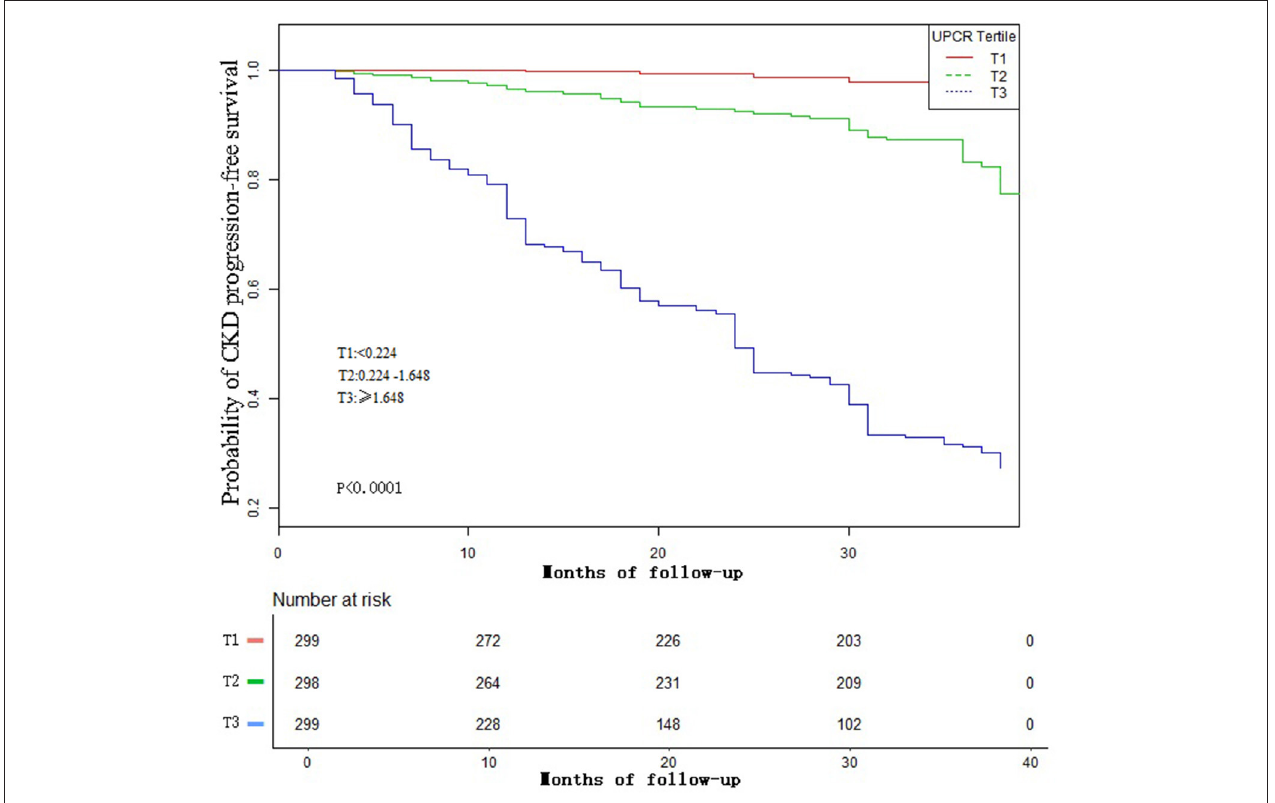
FIGURE 4 | Kaplan–Meier event-free survival curve. Kaplan–Meier analysis of incident CKD progression-free survival based on UPCR groups (log-rank, P < 0.0001).